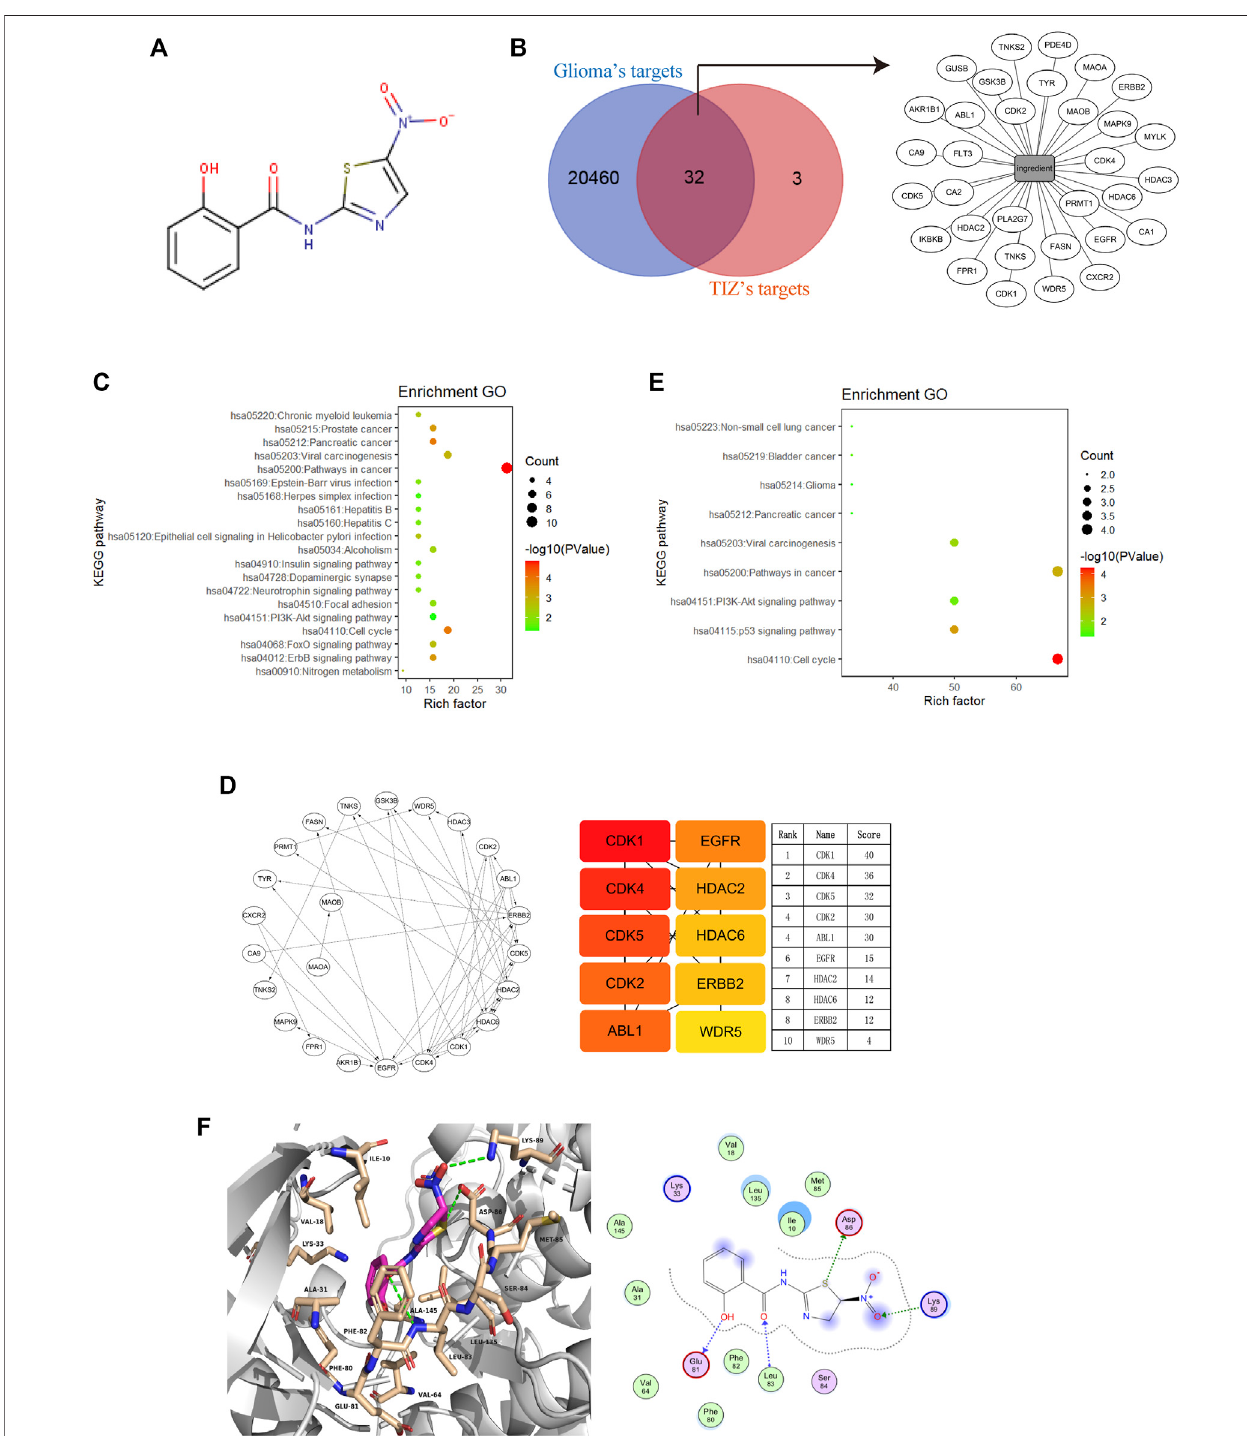
FIGURE2| Cyclin-dependentkinasesarepotentialtargetsofTIZagainstglioma. (A) ThestructureofTIZ. (B) VenndiagramofthesharedtargetsandtheTIZ-target network. The related targets of GBM and TIZ were obtained from GeneCards and SEAware, respectively. (C) KEGG pathway enrichment analysis of the top 20 target genes. (D) Schematicdiagramoftargetnetworkconnectionsandthetop10targetsandtheirscores.NetworkAnalyzerwasemployedtoanalyzethenode ’ sdegreeand related parameters. The color of nodes changed from orange to red, which indicates that the af fi nity degree gradually increases from weak to strong. (E) KEGG pathway enrichment analysis of targets whose score was greater than 15. (F) Docking diagram of CDK1 and TIZ. Key interactions include hydrogen bonds formed by multiple atoms of TIZ with ASP86, Lys89, Glu81, and Leu83.